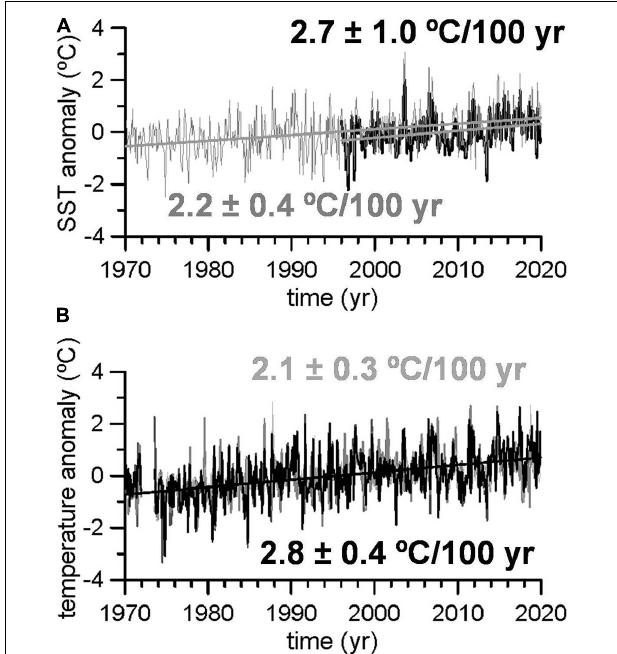
FIGURE 7 | (A) Temperature residuals or anomalies obtained from NCEP SST data at the Balearic Channels (black line, 39 ◦ –41 ◦ N, 1.9 ◦ –3.8 ◦ E) and at the Northern Sector (gray line, 41 ◦ –42.9 ◦ N, 1.9 ◦ –3.8 ◦ E). The Balearic Channels SST extends from 1996 to 2019, for comparison with the CTD time series. The Northern Sector time series extends from 1970 to 2019 for comparison with l’Estartit temperature time series. (B) Temperature residuals or anomalies at 0, 20, 50, and 80 m depth at the L’Estartit coastal station. The four time series are presented with different colors from black (0 m) to light gray (80 m), although they are not distinguished in this plot because they have very similar behavior.